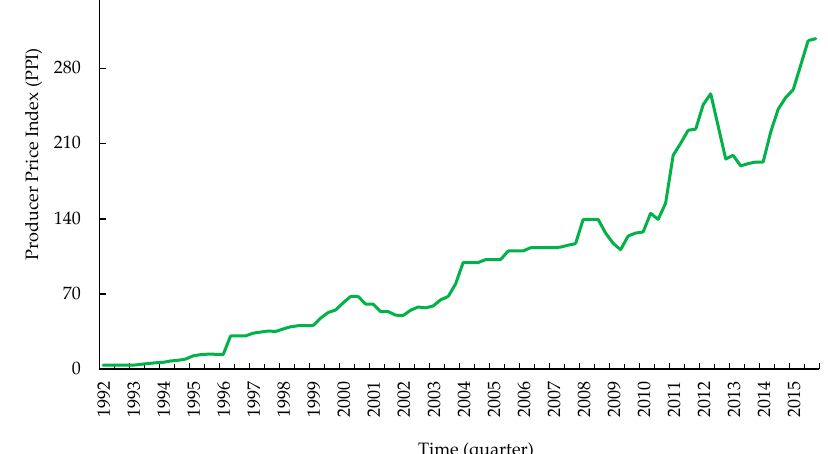
Figure A1. The variations of producer price index (PPI) between in study period.